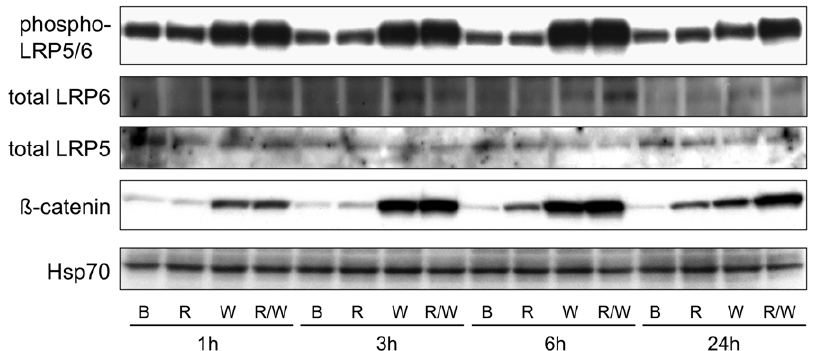
Figure 3. Time-course of Rspo2- and Wnt3a-dependent LRP5/6 phosphorylation and b -catenin stabilization. C57MG cells were treated with BSA, Rspo2 (100 ng/ml), Wnt3a (100 ng/ml) alone or in combination for the indicated periods. Cell lysates (30 m g protein/lane) were immunoblotted for phosphorylated LRP5/6, total LRP5, total LRP6 and Hsp70, the latter serving as a loading control. Soluble b -catenin was measured by immunoblotting after pull-down with GST-E-cadherin.